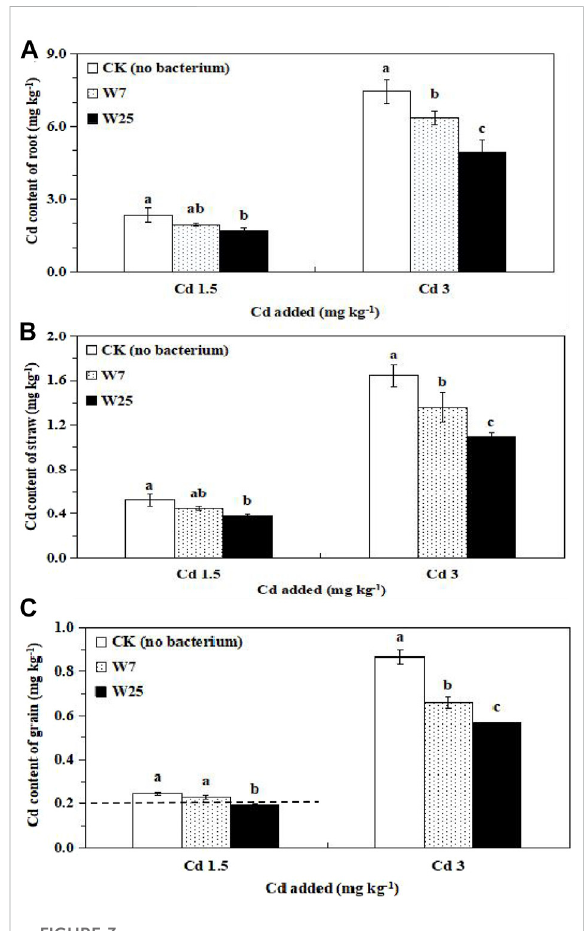
FIGURE 3 Effects of strains W7 and W25 on Cd contents of root (A) , straw (B) and grain (C) of wheat plants grown in low and high Cd- contaminated soils. Error bars are ± standard error ( n = 3). Bars with the same letter are not signi fi cantly different ( p > 0.05) according to Tukey ’ s test. Dotted line corresponds to